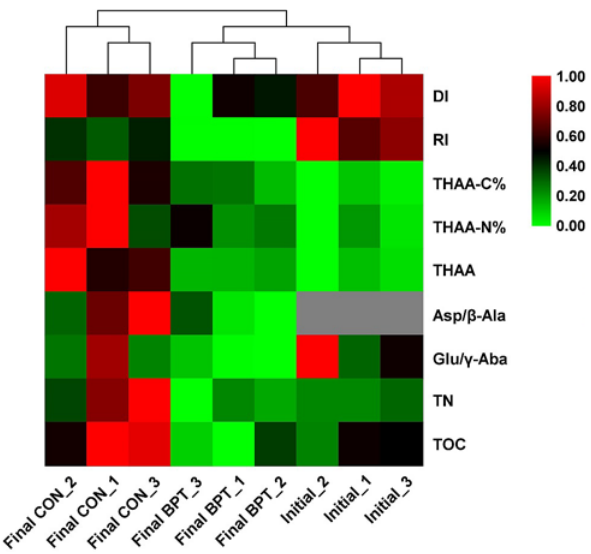
Fig. 2. Heat-map visualization of different indexes related to organic matter degradation in sediments of the final Bel- lamya purificata treatment (BPT), final control (CON), and initial samples (n = 3 replicates per group). For each row, colour represents the relative values of each index in differ- ent groups, from the highest (red) to the lowest (green). Note: β -Ala was not detected in the initial sediment samples, therefore the colour of the Asp/ β -Ala ratio in the Initial_1, Initial_2, and Initial_3 is grey. DI: degradation index; RI: reactivity index; THAA-C% (THAA-N%): carbon-